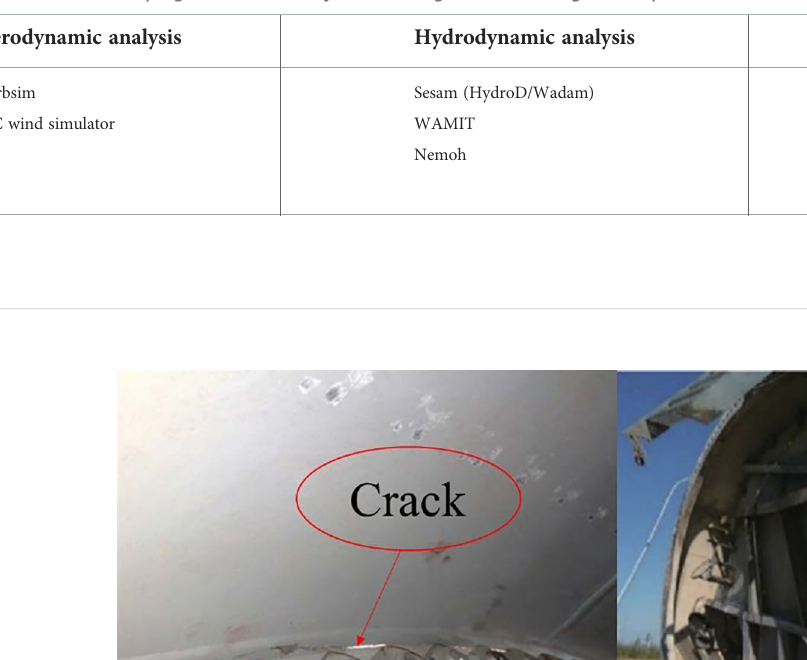
TABLE 1 Numerical programs for the analysis of fl oating wind turbines ’ global